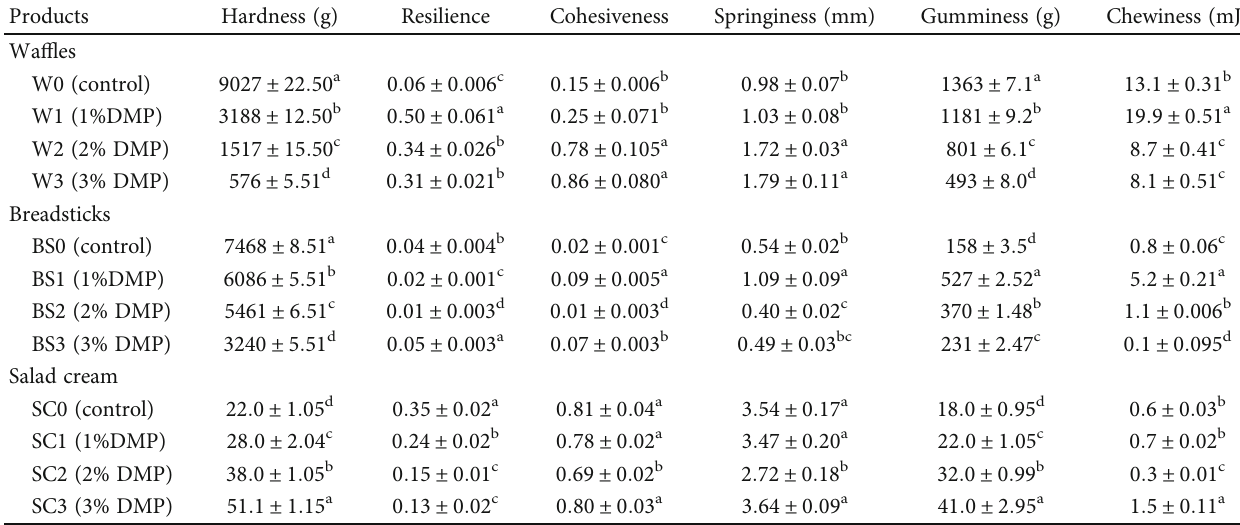
Table 8: Texture pro fi le analysis of wa ffl es, breadsticks, and salad